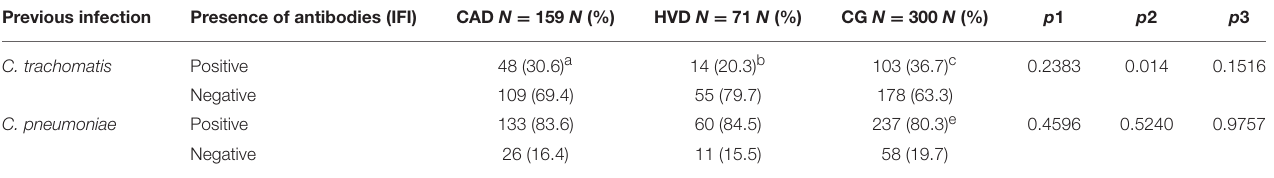
TABLE 2 | Frequency of antibodies to C. trachomatis and C. pneumoniae among cardiac patients (CAD and HVD) investigated. Previous infection